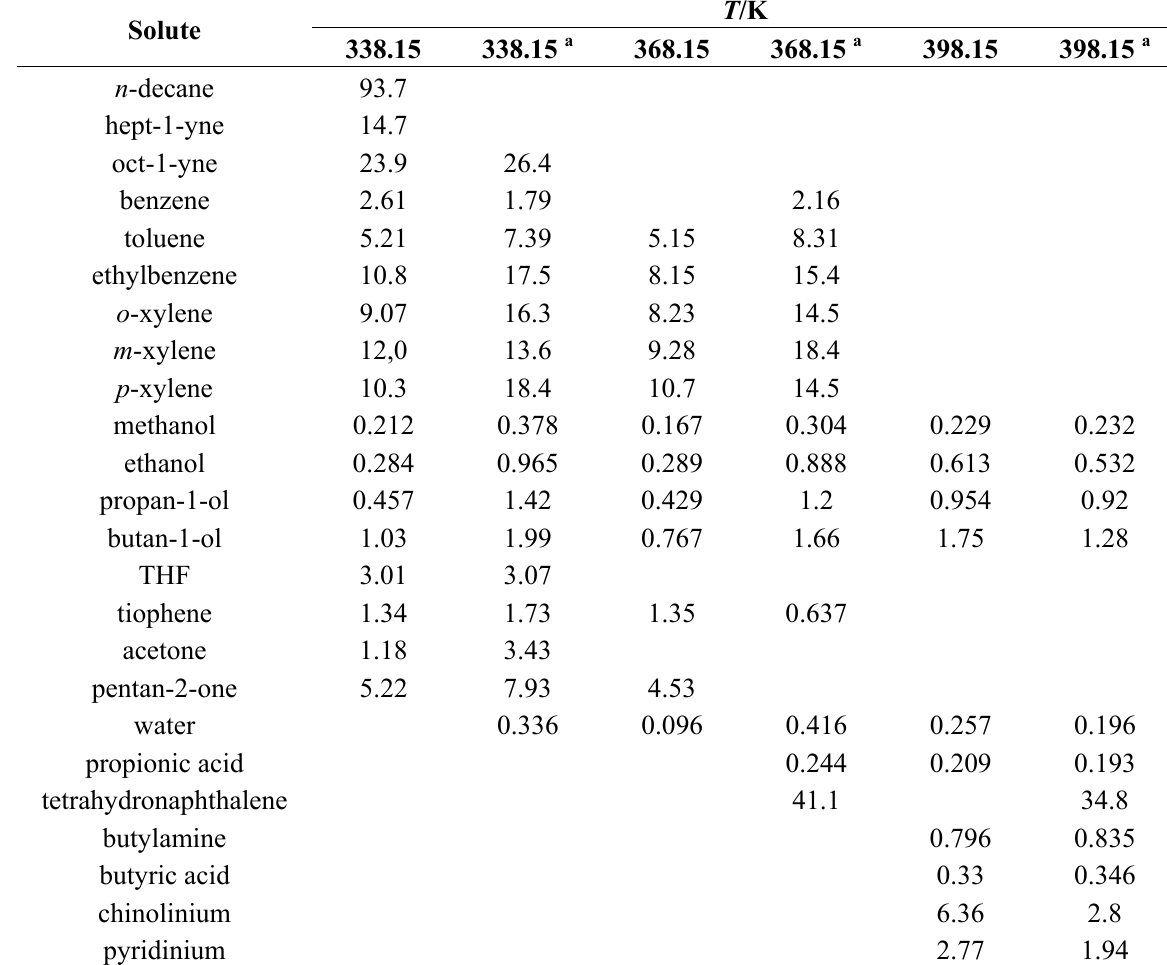
Table 1. The experimental activity coefficients at infinite dilution, ∞ IL [EMIM][Br] (12.20 w %) and IL {[EMIM][Br] (12.20 w %) + β -CD (17.42 w %)} at different